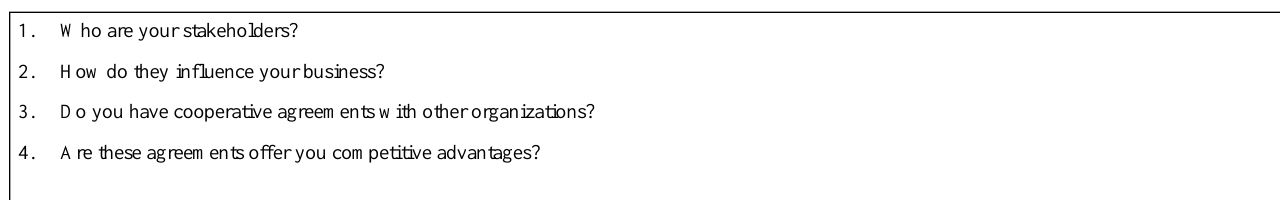
Textbox 1. Interview questions used with the focus